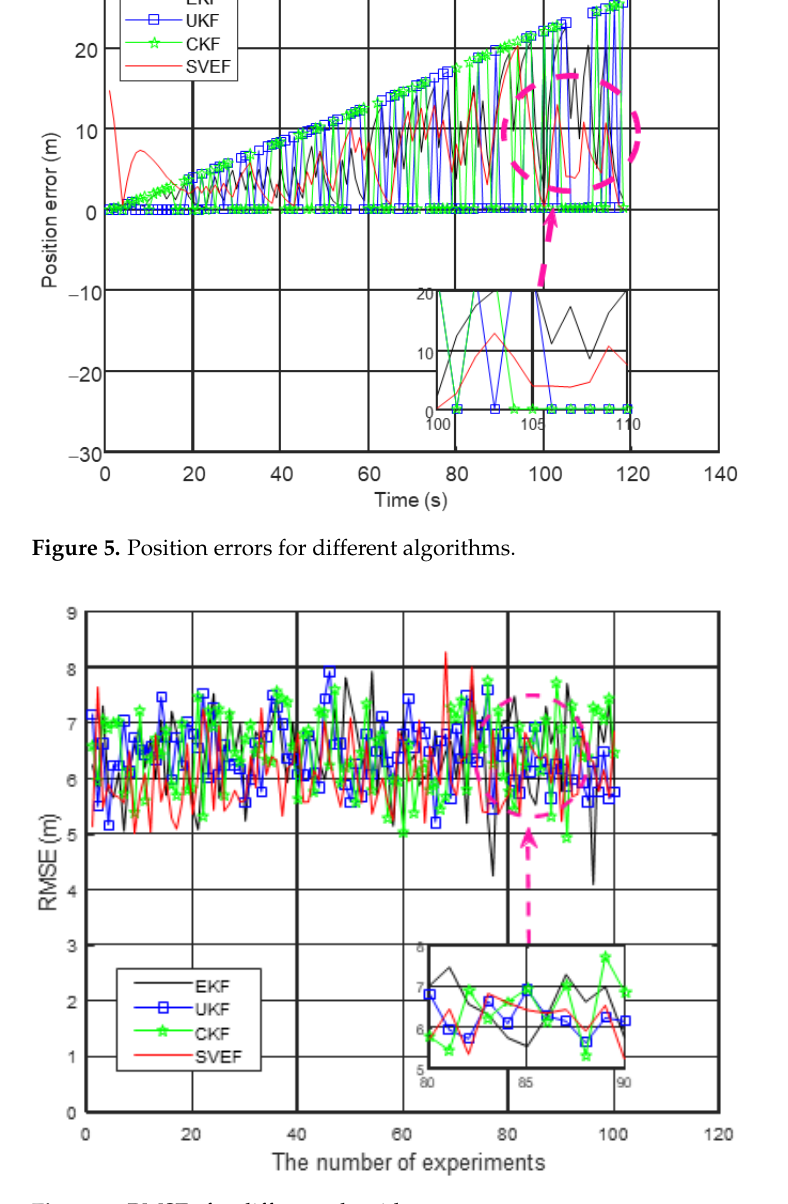
Figure 6. RMSEs for different algorithms. Table 2. MC RMSE for different